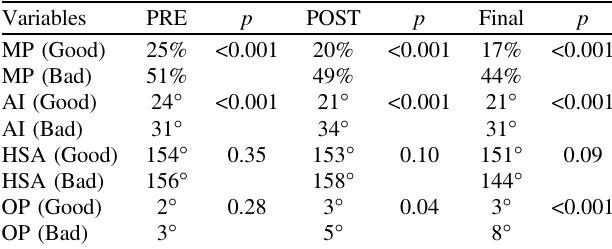
Table 1. Preoperative (PRE), postoperative (POST) and fi nal mean radiographical measurements and differences according to Student ’ s t or Mann – Whitney ’ s tests.